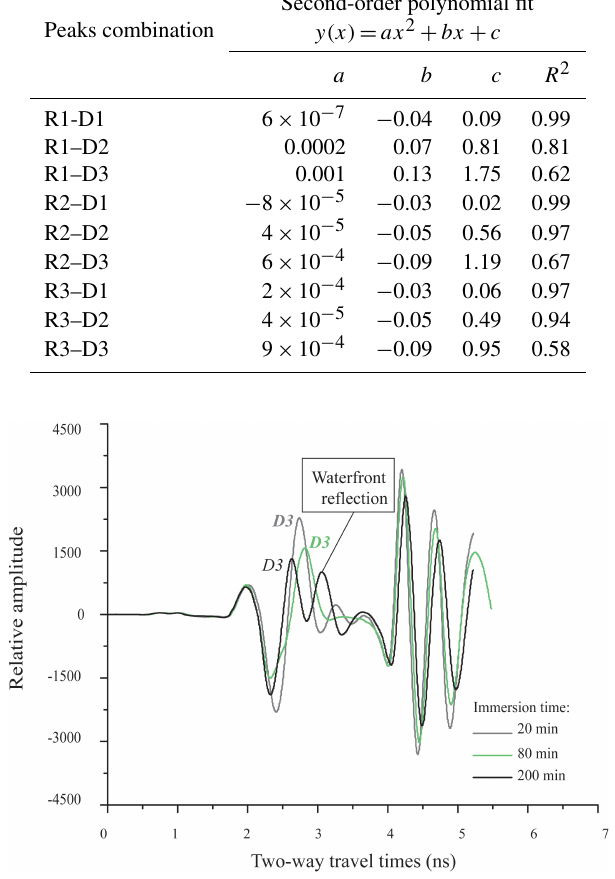
Figure 4. Overlap between peak D3 of direct wave and waterfront